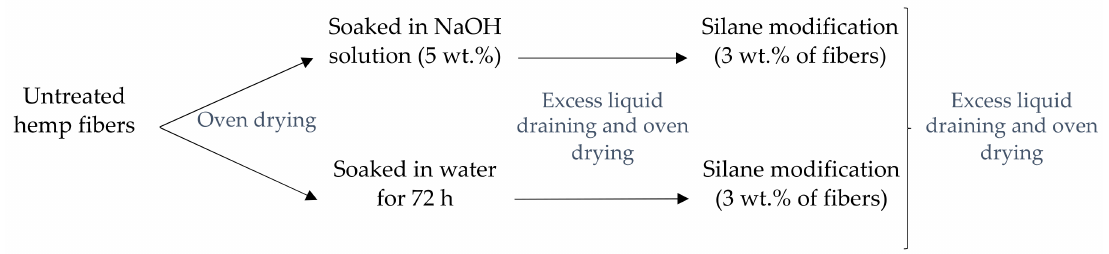
Figure 2. The surface pretreatments and treatment of hemp fibers. Hemp fibers are pretreated to eliminate non-cellulosic compounds (hemicellulose, lignin and pectins). The elimination of these components results in a loss of fiber